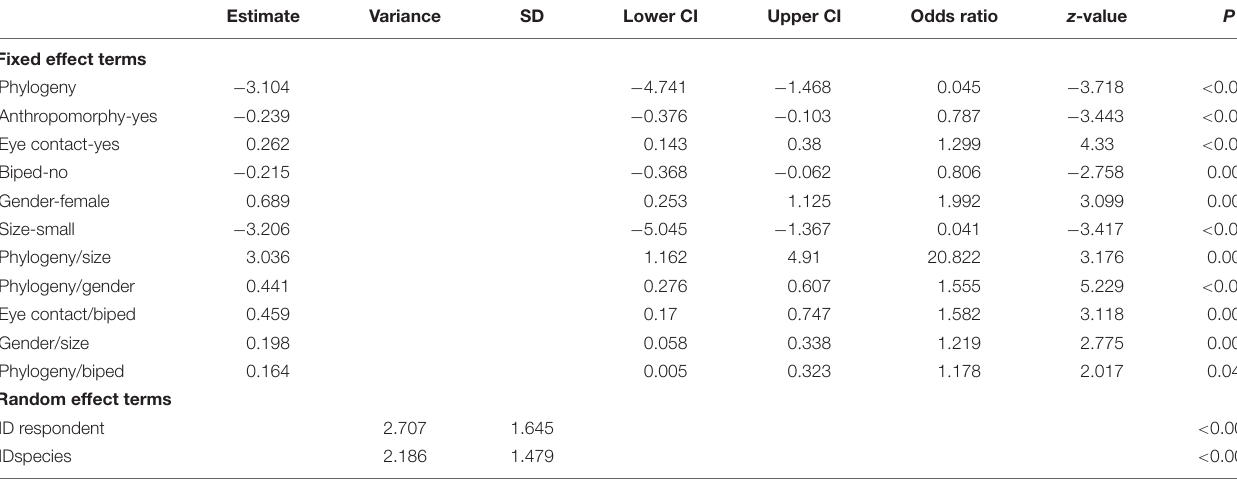
TABLE 4 | Results of the cumulative link mixed model on the respondent’s fear ratings. Estimate Variance SD Lower CI Upper CI Odds ratio z -value P